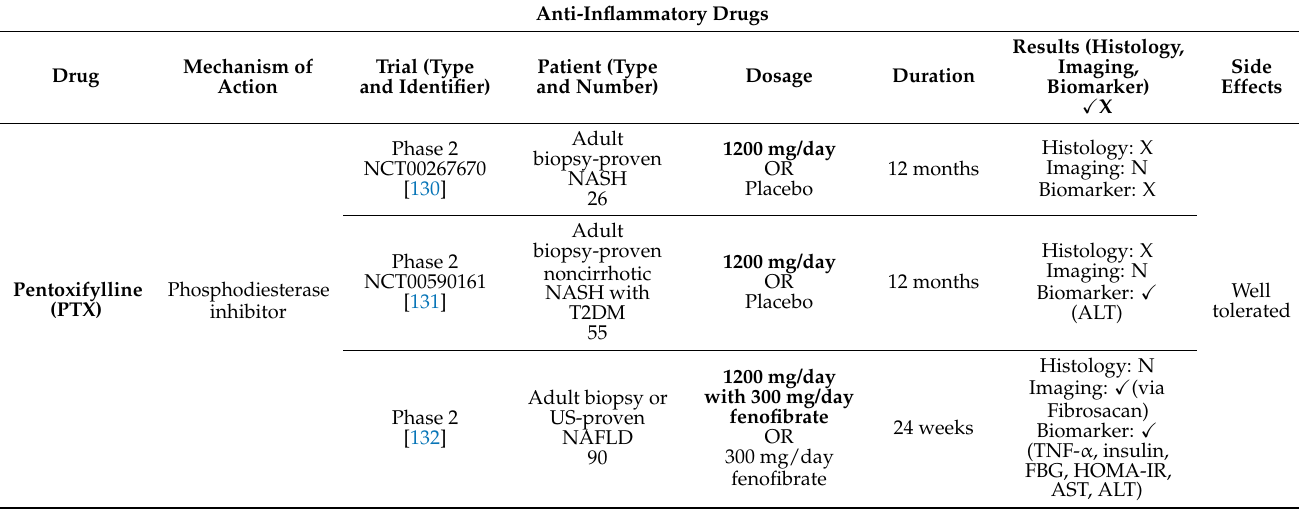
Table 8. Clinical trials on anti-inflammatory drugs